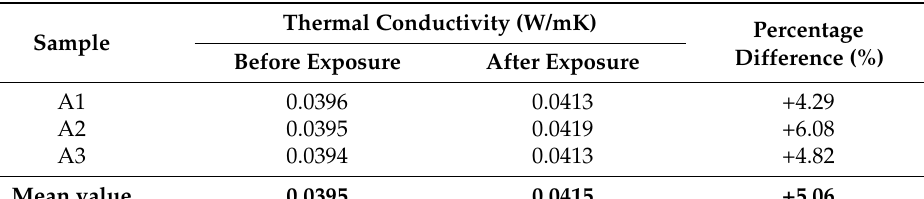
Table 5. Summary of thermal conductivity measurement values before and after environmental exposure.